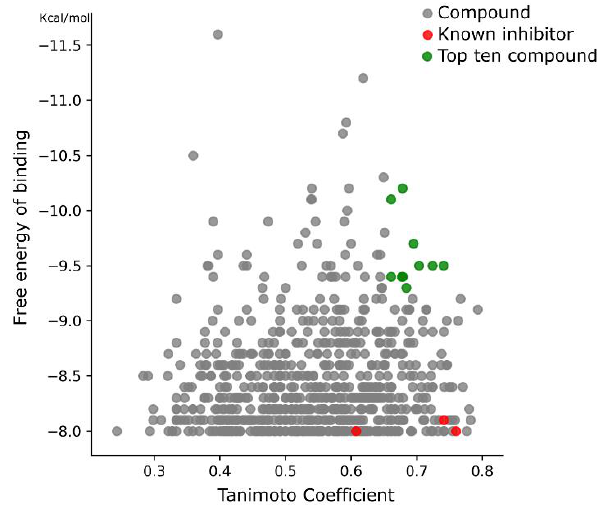
Figure 6. Ranking of compounds from the Tc DHFR-TS virtual screening. Compounds in green are the top ten ranked based on both criteria.